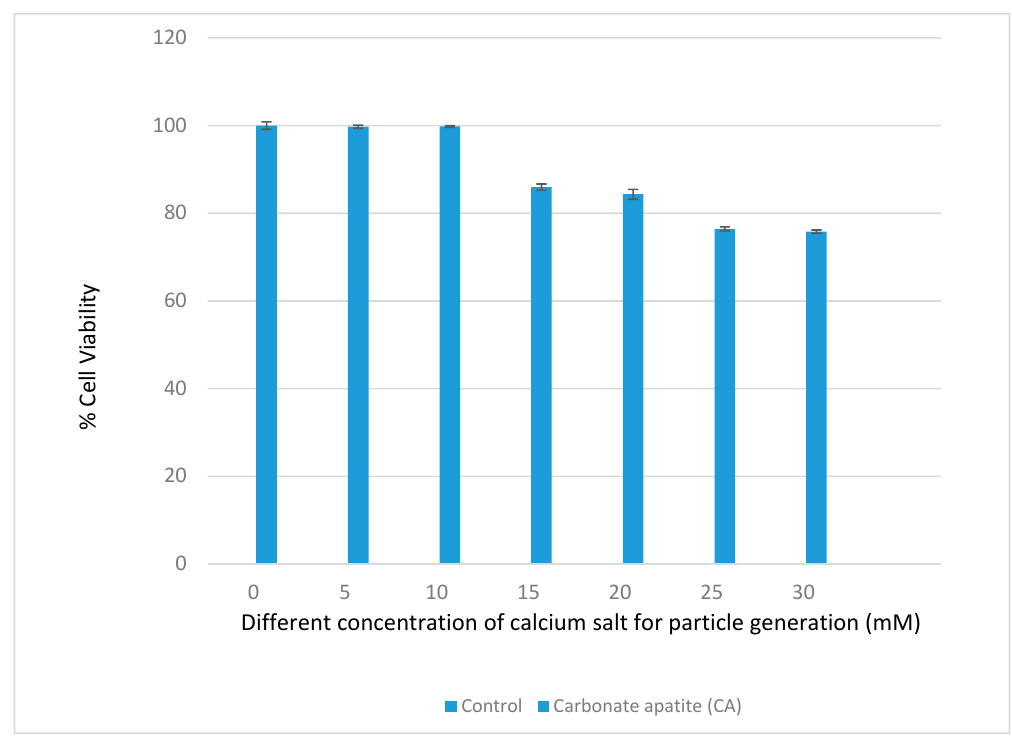
Figure 2. Assessment of the cytotoxicity of CA nanoparticles (NPs) in MCF-7 cells. MCF-7 cells were incubated for a consecutive period of 48 h with the particles formulated with different concentrations of calcium chloride and subjected to assessment for cell viability by MTT assay. The data are presented as the mean ± SD of triplicates.